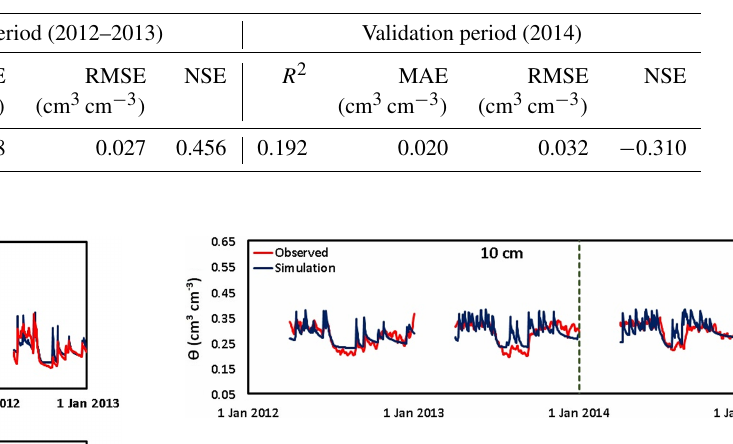
Figure 8. Daily observed and simulated SWC ( θ ) during the cali- bration (2012–2013) and validation (2014) periods at the location of the cosmic-ray neutron